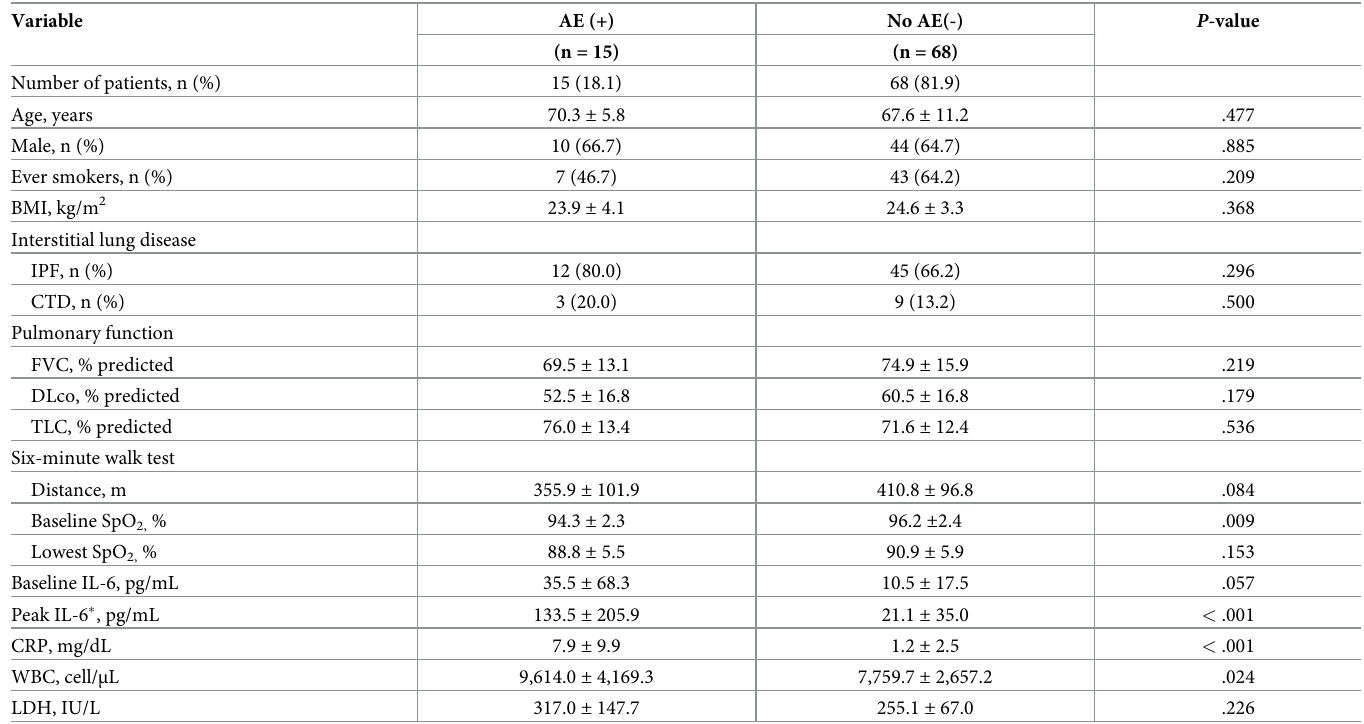
Table 2. Comparison of characteristics between ILD patients with and without